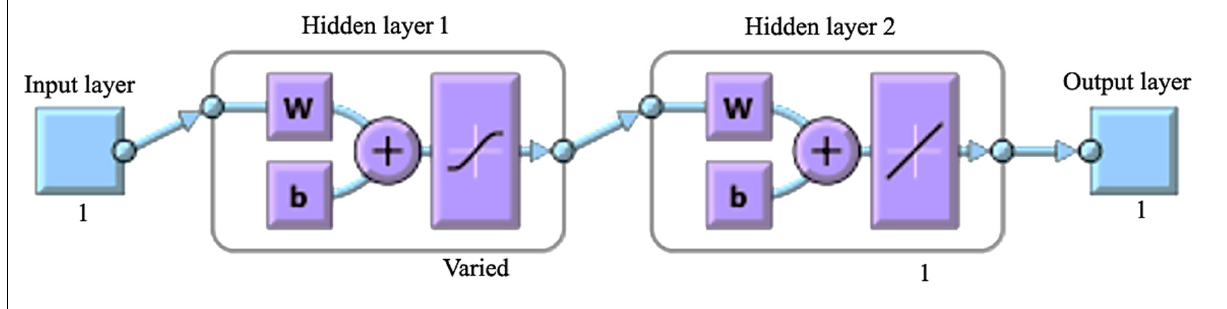
Figure 1. Representative ANN model. Note: w = weight; b = bias. Table 5. Maximum and minimum values of nutrient